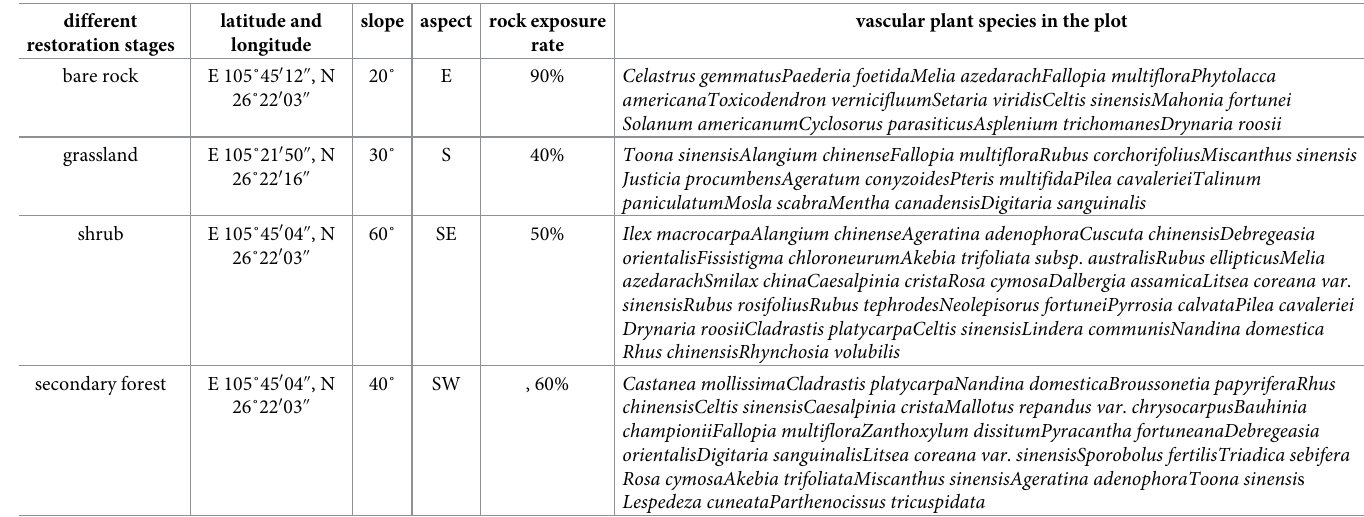
mosses were used to calculate the ecological importance of the species. The dominant species Table 1. Habitat characteristics of the